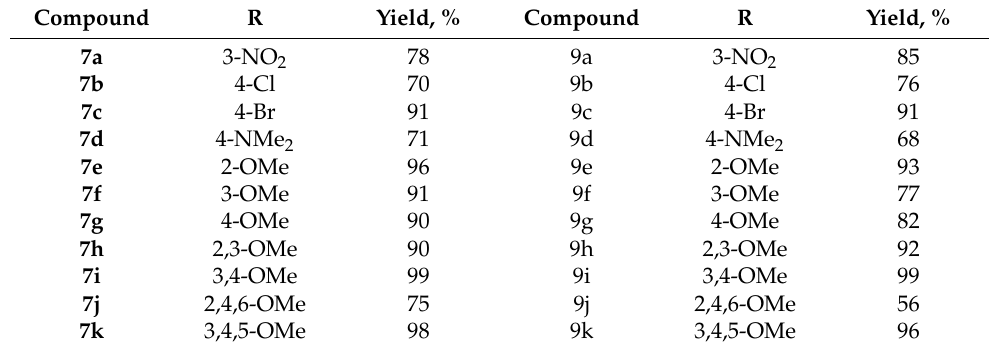
Table 1. Yields of pyrazolines.